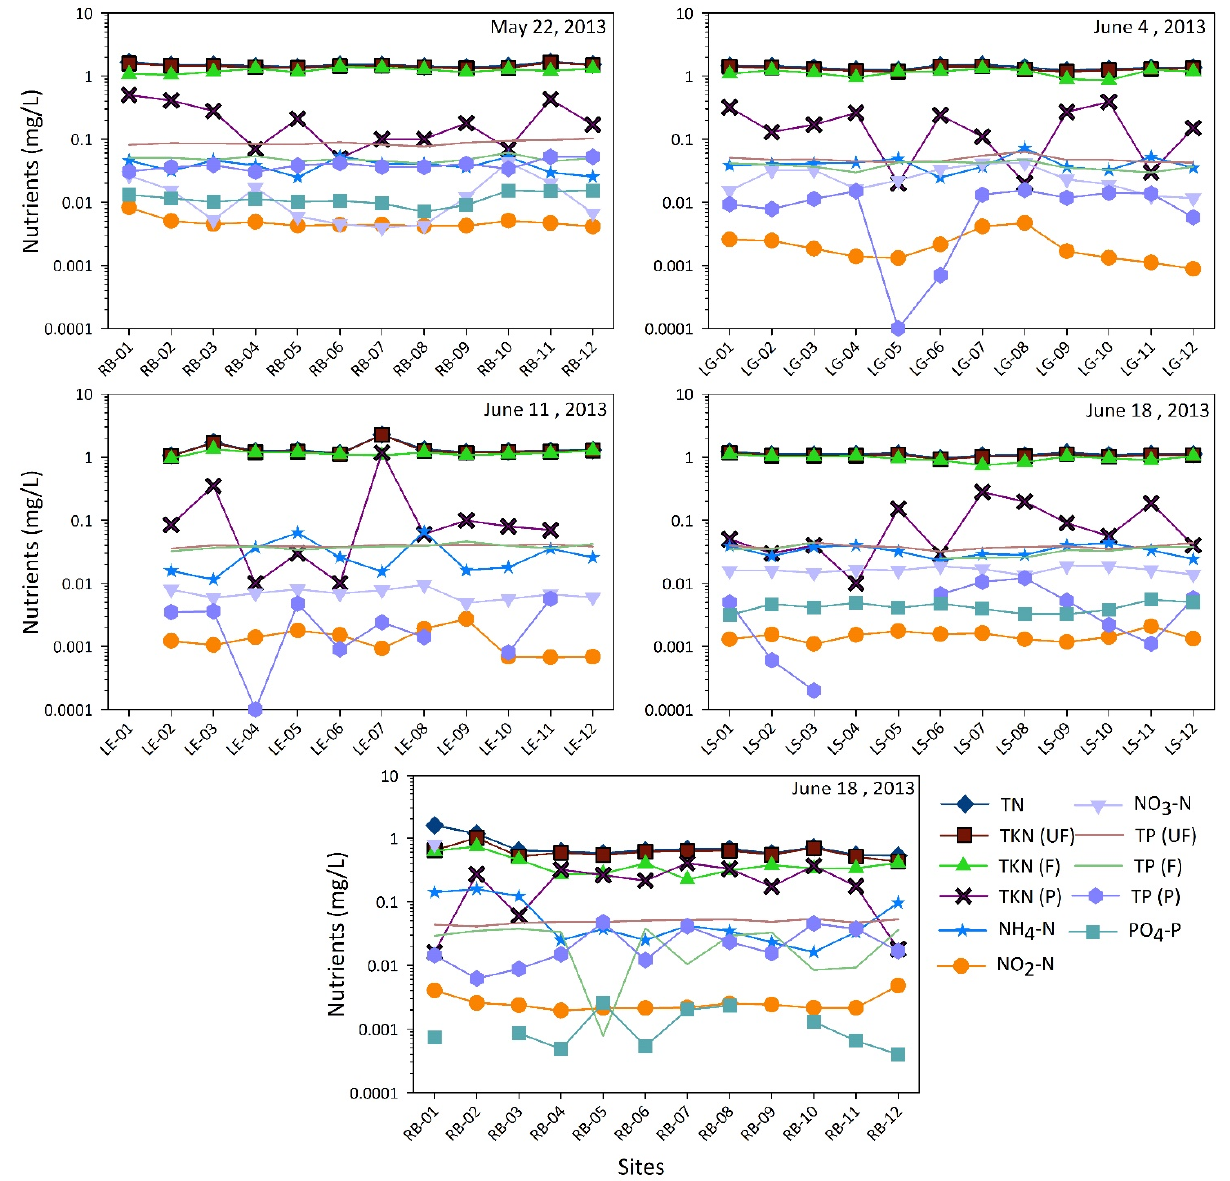
Figure 8. Nutrients at twelve sampling sites in each of the lakes (RB = Ross Barnett Reservoir, LG = Lake Grenada, LE = Lake Enid, and LS = Lake Sardis) with sampling dates